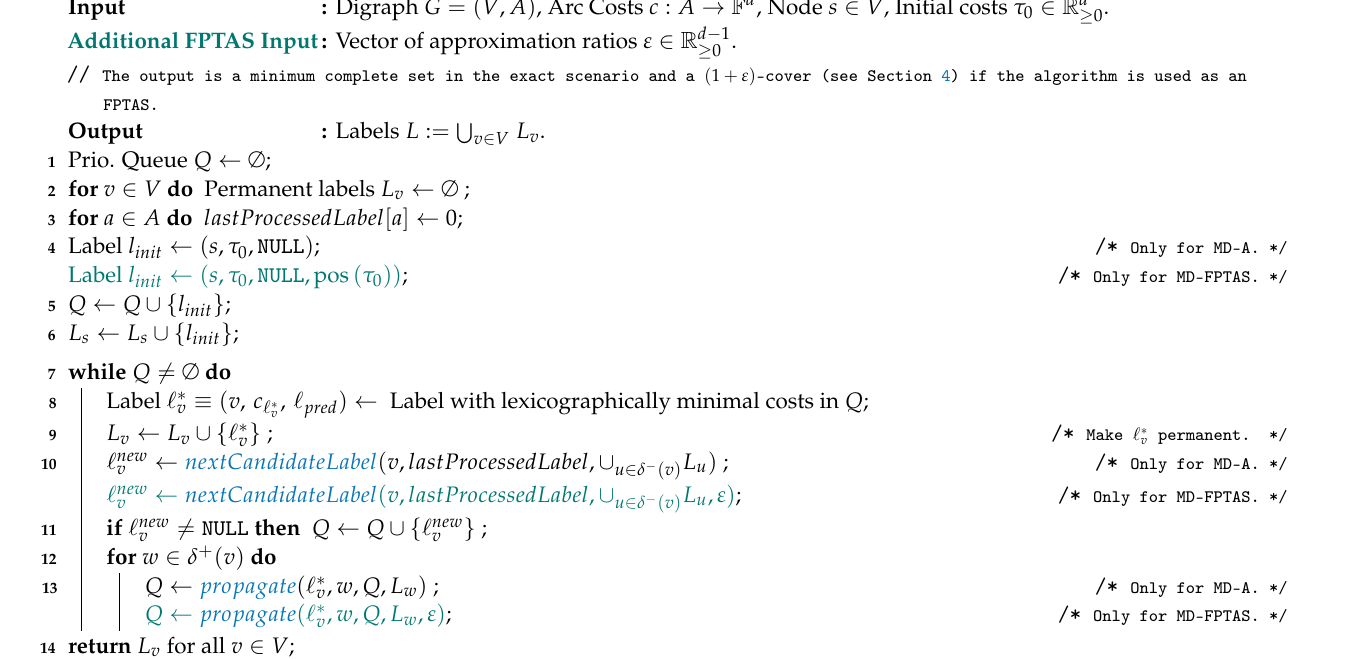
Algorithm 1: Multiobjective Dijkstra Algorithm (MD-A) Blue code only for the MD-FPTAS described in Section 4.